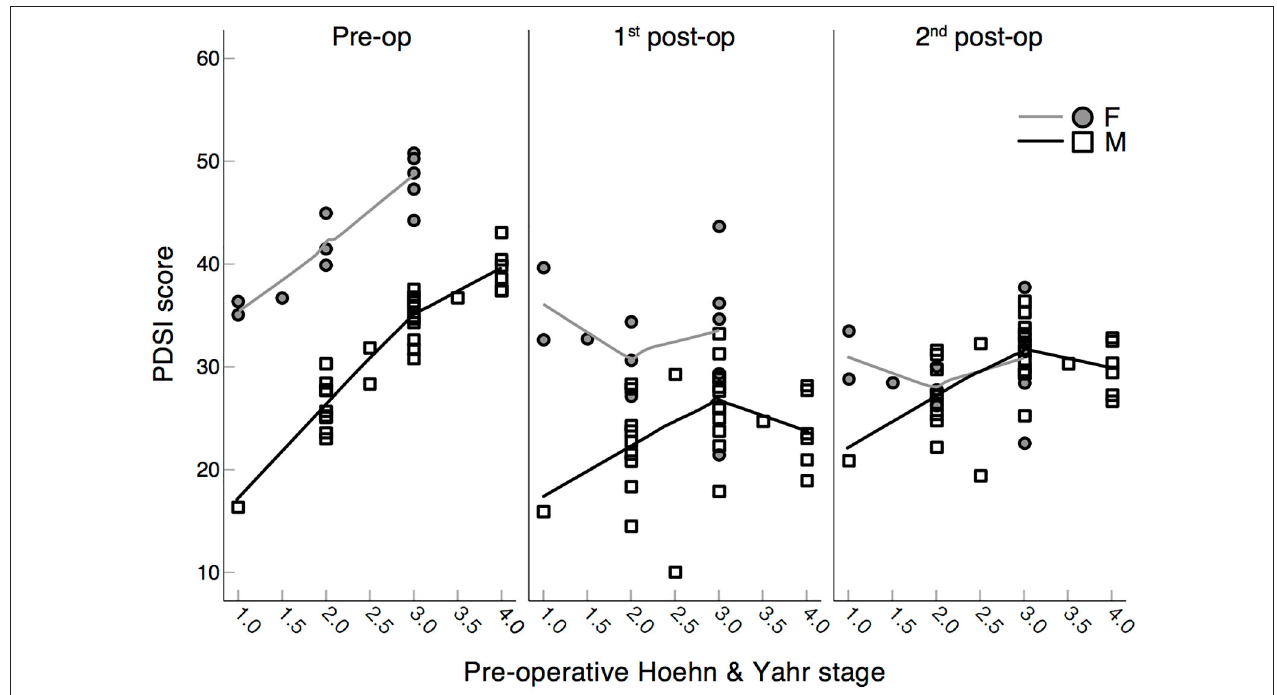
FIGURE 5 | Scatter plots of PDSI scores (PDQ-39) and pre-operative Hoehn & Yahr stage. Assessment of scores in PD patients at the three experimental stages: pre-operation, 1st post-operation, 2nd post-operation separated by sex: F = female, M = male. Higher PDSI scores correspond to a worse QoL. Lines represent Loess fit lines with 99% proportion of data points and Epanechnicov’s kernel